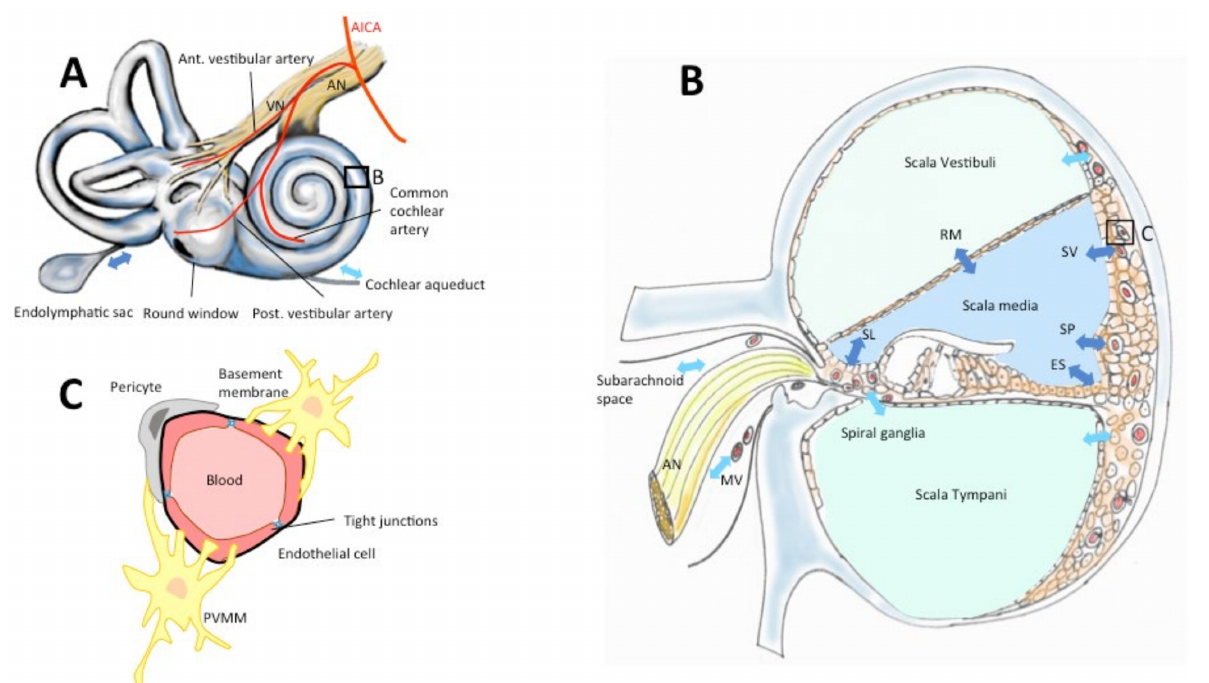
Figure 2. The blood–inner-ear barriers. Drugs reach the inner ear via the vascular compartment, cerebrospinal fluid or the labyrinthine windows (round, oval, A ). The inner ear is vascularized by terminal branches of the anterior-inferior cerebellar artery (AICA, A ). Perilymph contained in scalae vestibuli and tympani ( B ) is secreted and absorbed through the scala vestibuli vessels, the subarachnoid space, the modiolar vessels (MV), the capillary region in scala tympani, and the cochlear aqueduct ( A , B , light blue arrows). Endolymph in the scala media is secreted and absorbed via stria vascularis (SV), Reissners’s membrane (RM), spiral limbus (SL), spiral prominence (SP), external sulcus (ES), endolymphatic sac ( A , B , dark blue arrows). ( C ) Vessels in the inner ear epithelia are surrounded by endothelial cells with tight junctions, a double-layer basement membrane, pericytes and perivascular-resident macrophage-like melanocytes (PVMM) also called intermediate cells (according to Juhn & Ryback, 1991, Nyberg et al. 2019